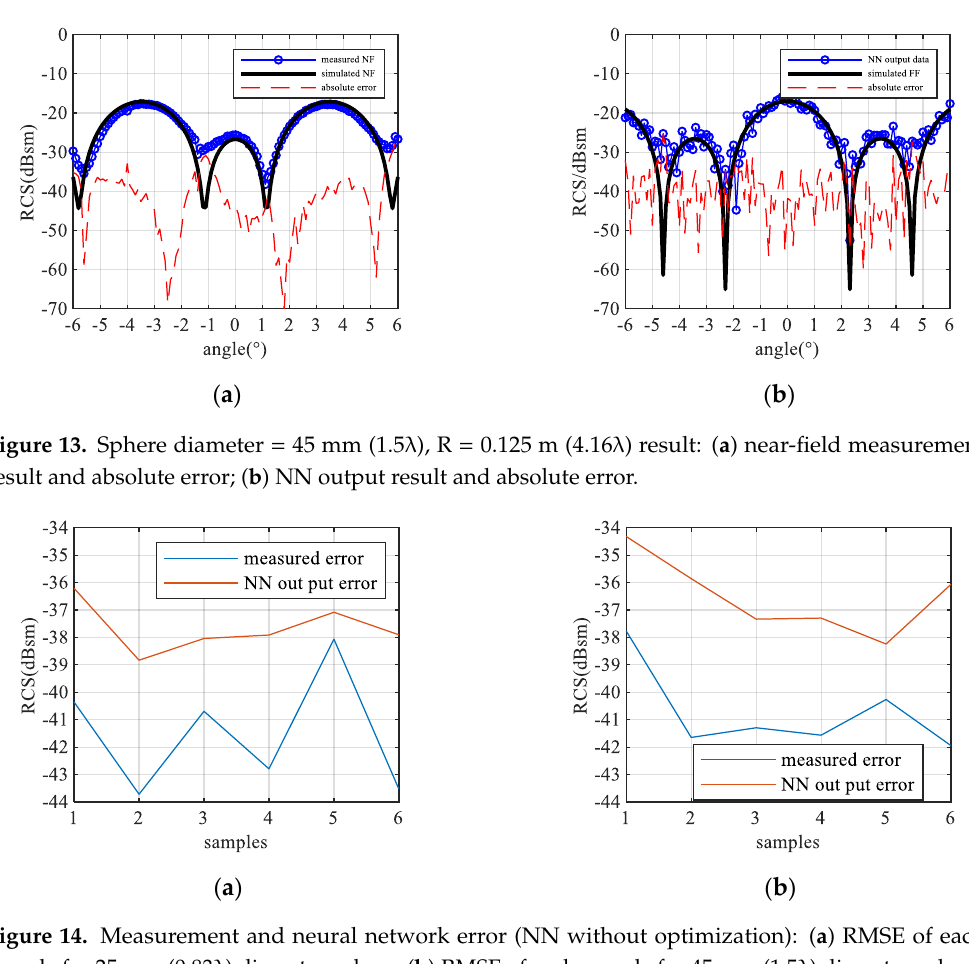
Figure 12. Sphere diameter = 25 mm (0.83λ), R = 0.21 m (7λ) result: ( a ) near-field measurement result and absolute error; ( b ) NN output result and absolute error.